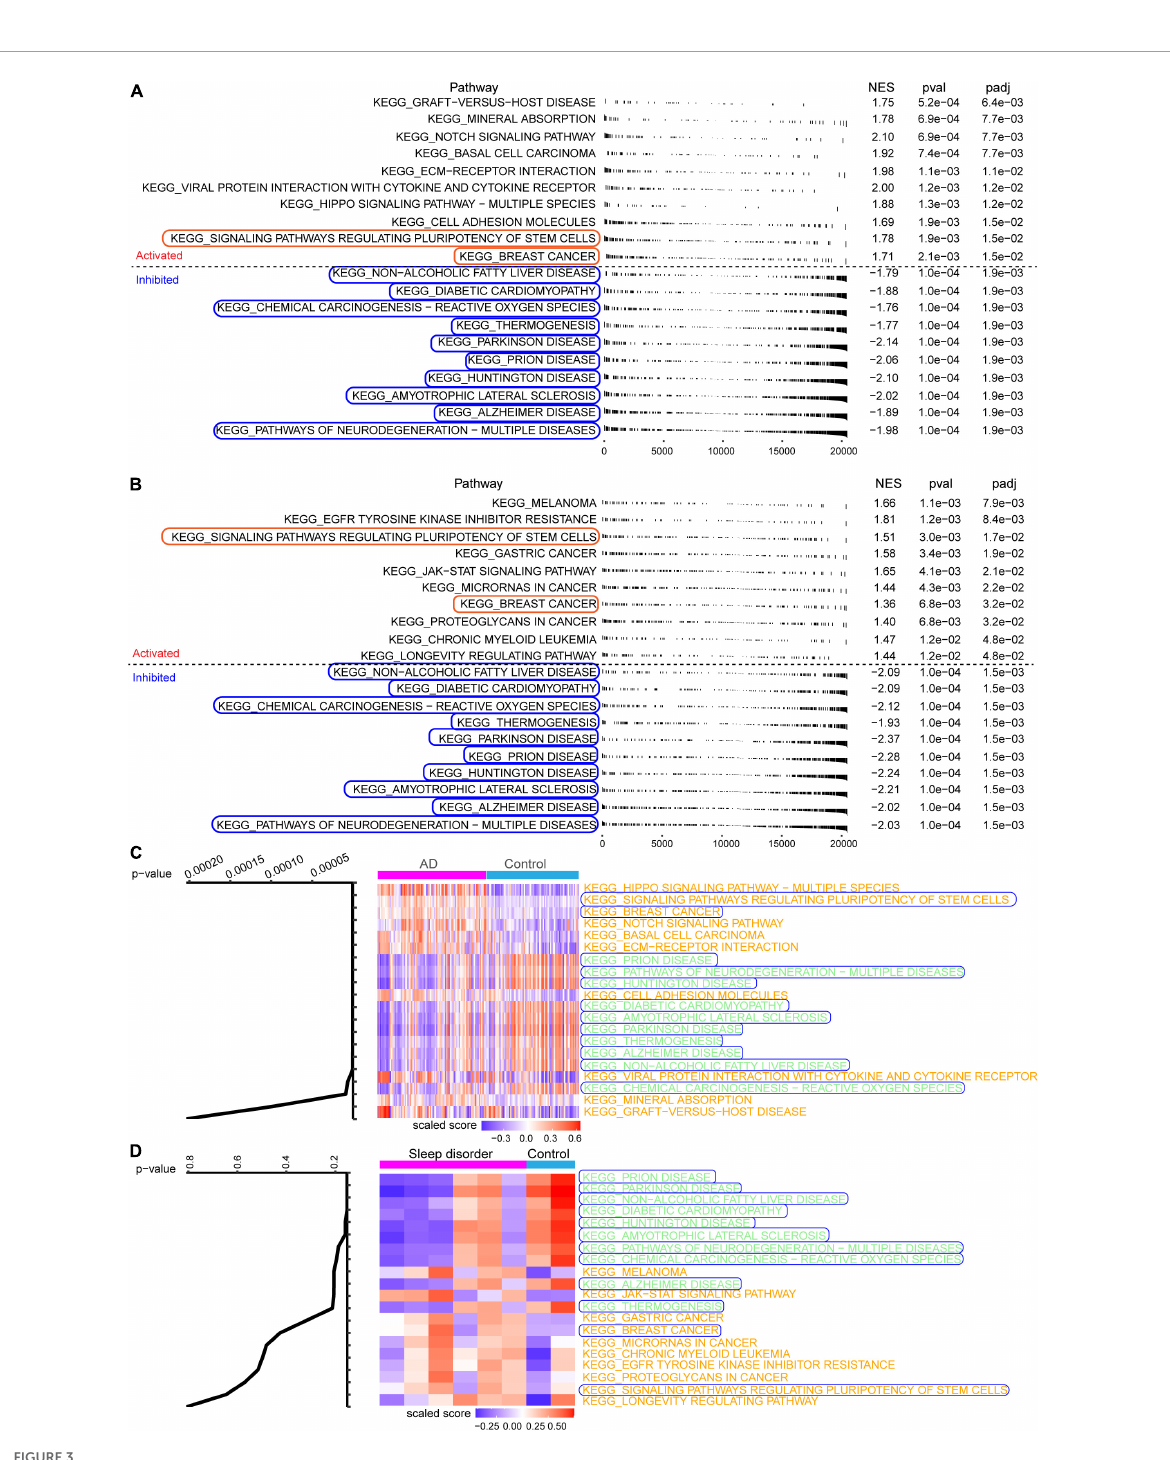
common genes in GSE5281 and GSE40562 datasets, of which four were upregulated and 106 downregulated ( Figure 5D and Supplementary Figure 1 ). Furthermore, the top 10 genes